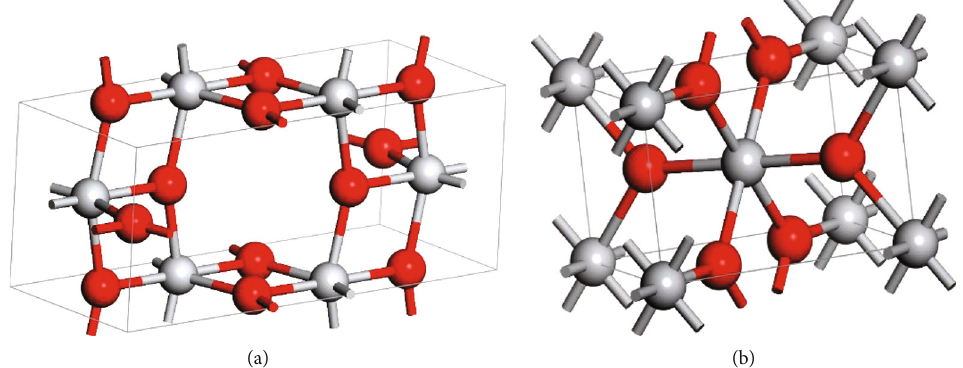
Figure 3: Simulations of anatase and rutile nanosized titanium dioxide. (a) Anatase type. (b) Rutile type.